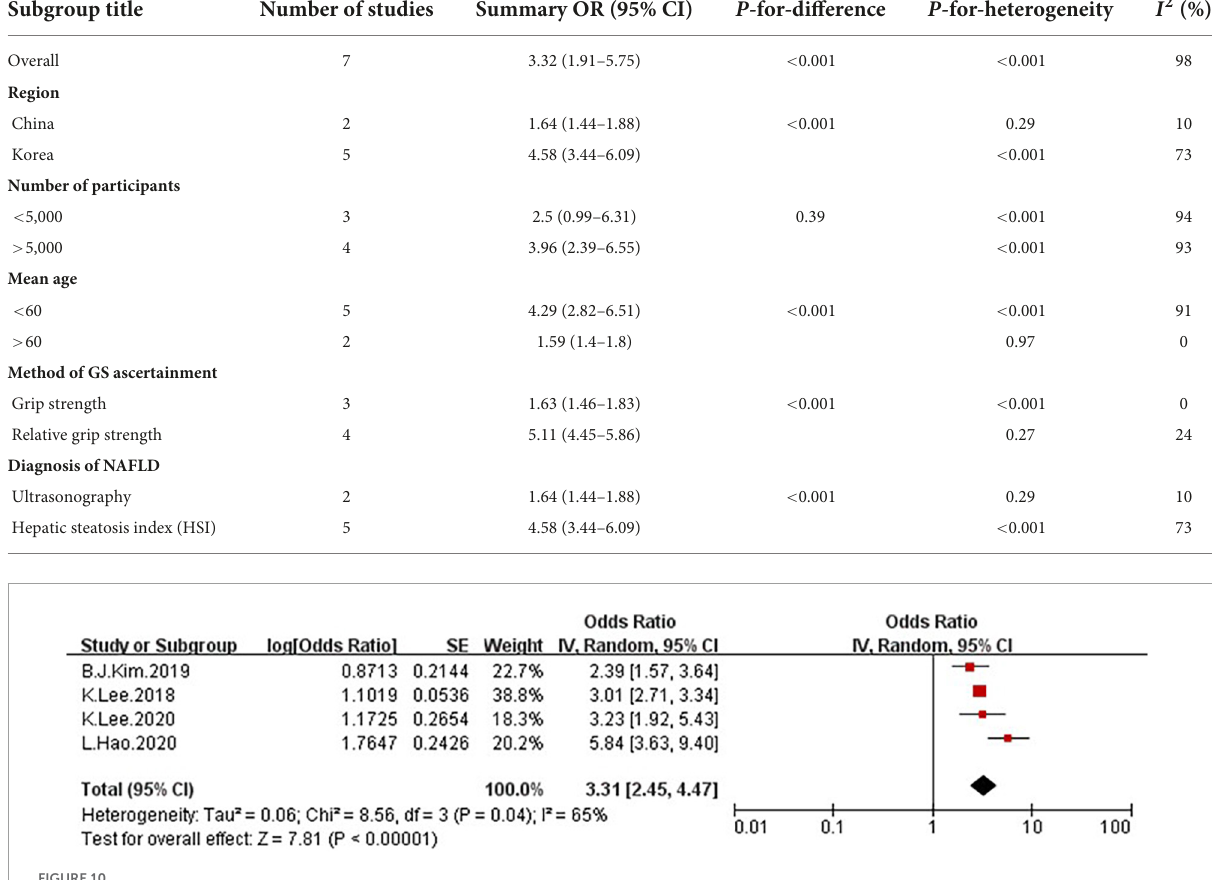
FIGURE10 Forest plots showing the relation between NAFLD and risk of low grip